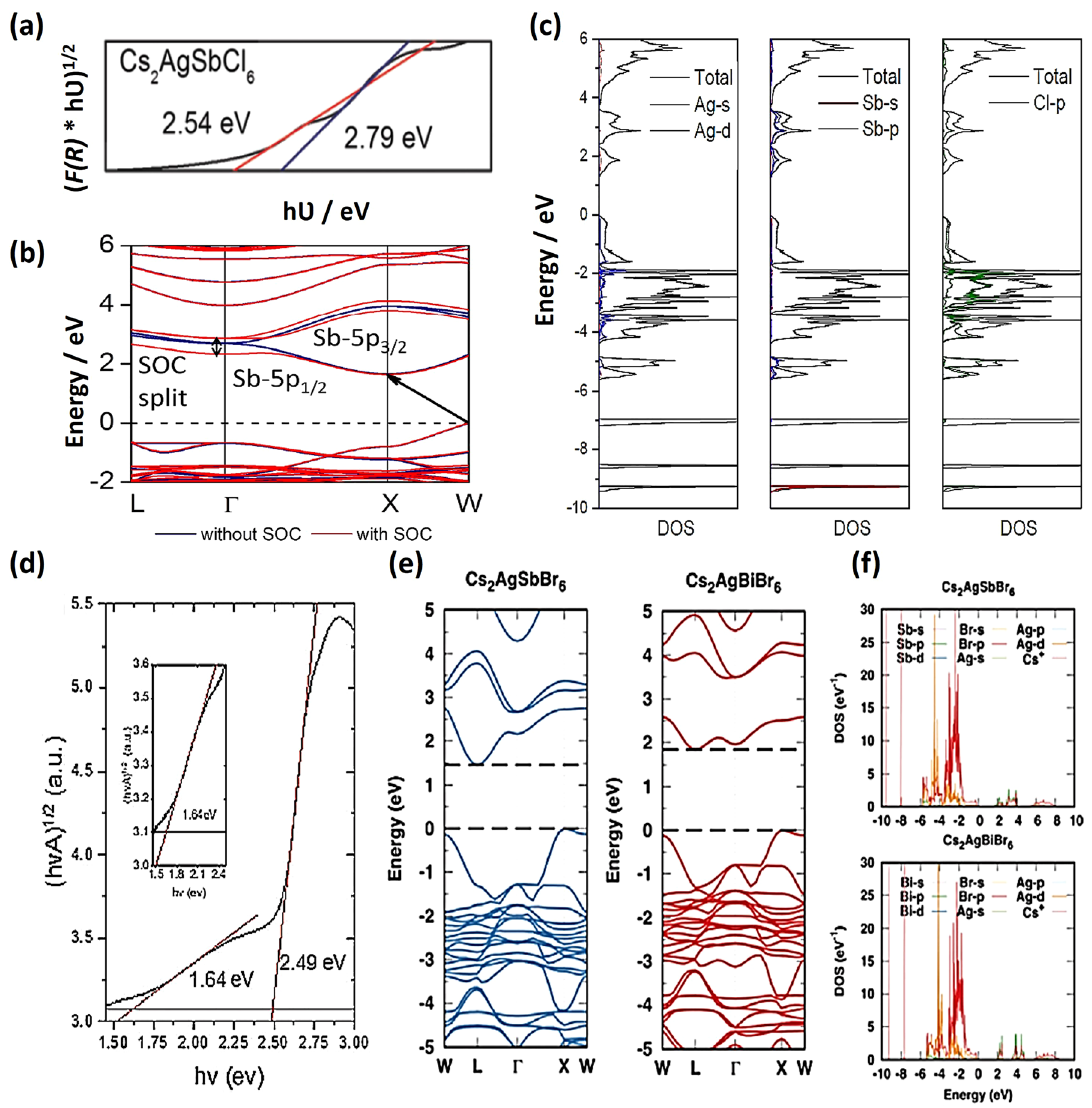
Figure 3: (a) Tauc plots for Cs 2 AgSbCl 6 double perovskite [92]. Copyright 2015, Royal Society of Chemistry. (b) Band structure of Cs 2 AgSbCl 6 double perovskite. (c) PDOS of Cs 2 AgSbCl 6 double perovskite [92]. Copyright 2015, Royal Society of Chemistry. (d) Tauc plot of a black sample of Cs 2 AgSbBr 6 powder[94].Copyright2015,RoyalSocietyofChemistry.Theinsetshowstheindirectbandgapabsorptionedge.(e)Calculated electronic band structures of Cs 2 AgSbBr 6 and Cs 2 AgBiBr 6 double perovskites [94]. Copyright 2015, Royal Society of Chemistry. (f) PDOS